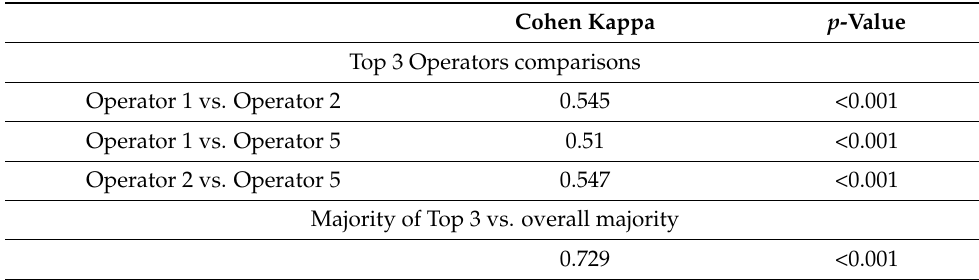
Table 2. The agreement for the requirement of invasive evaluation.